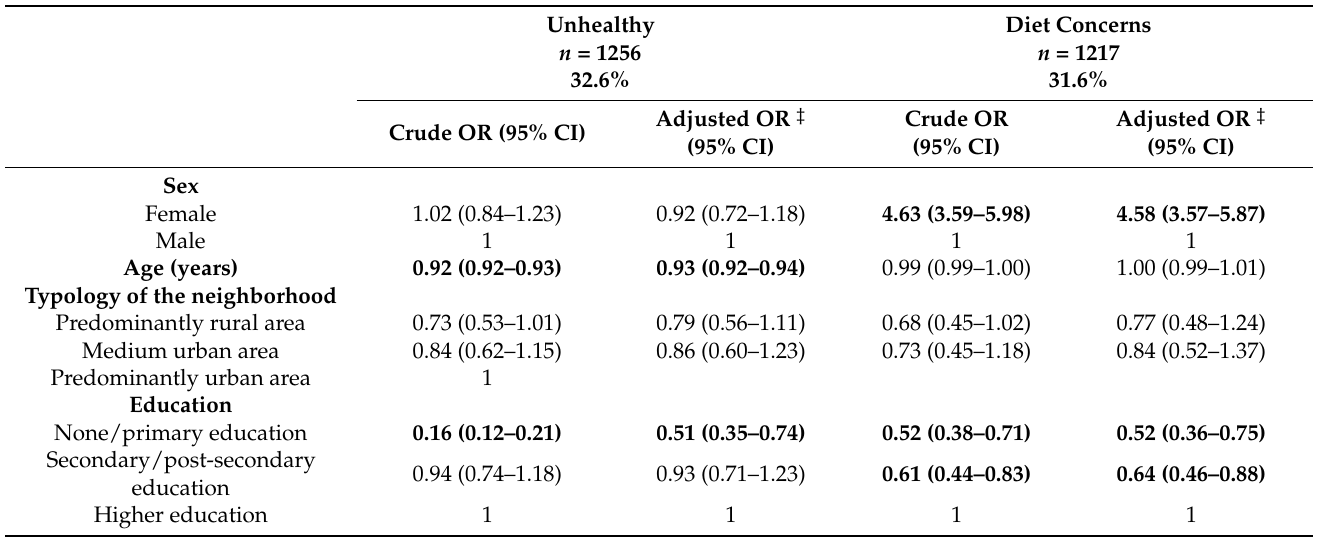
Table 3. Multinomial logistic regression analysis of the associations between sociodemographic and dietary patterns among Portuguese population aged 18–84 (Unhealthy and Diet concerns vs. Traditional): The UPPER